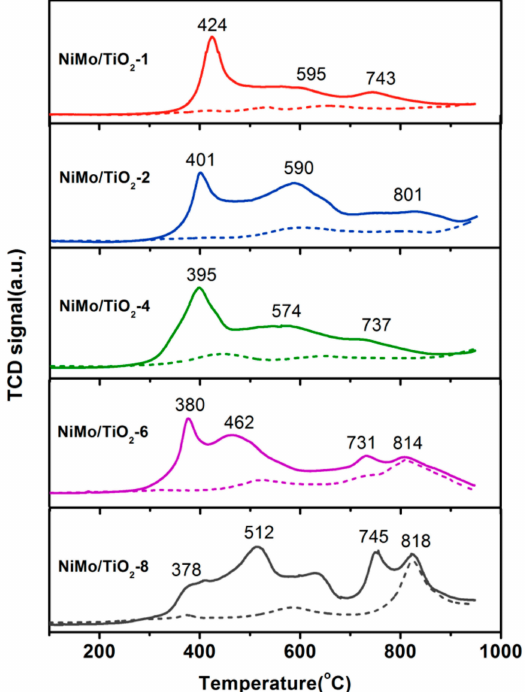
Figure 5. H 2 -TPR profiles of various catalysts (solid lines) and their corresponding supports (dashed